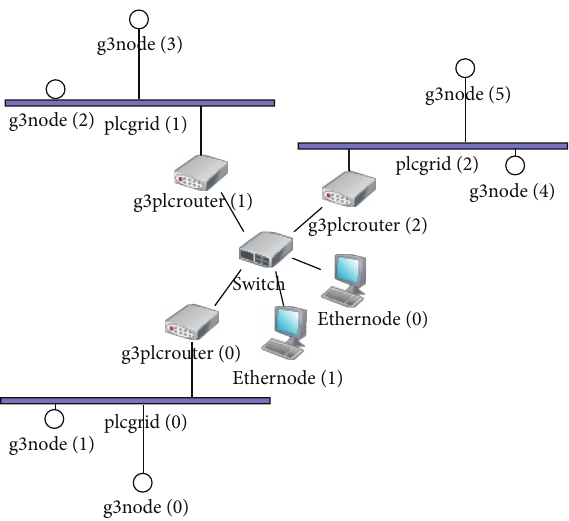
F 5: Screenshot of an example of convergent network simulation in OMNET++.